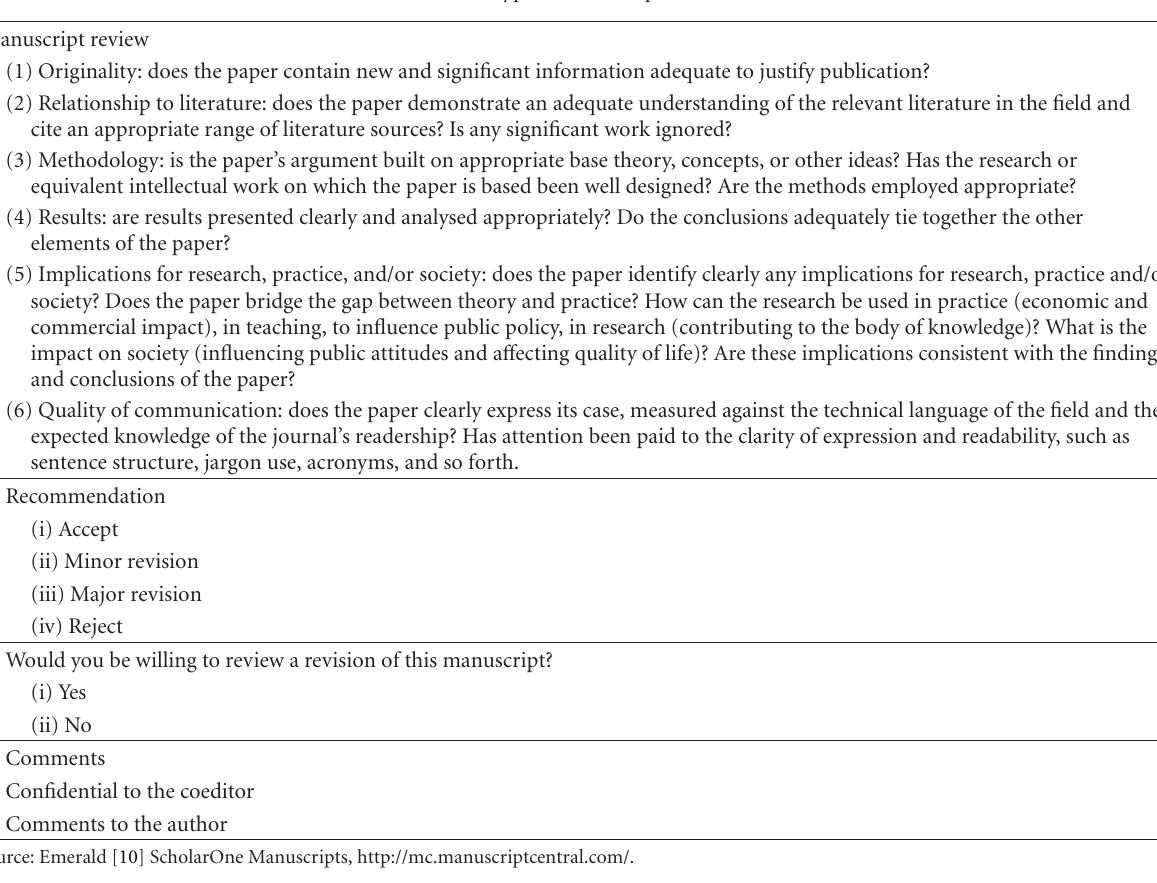
Table 10: Typical manuscript review format.